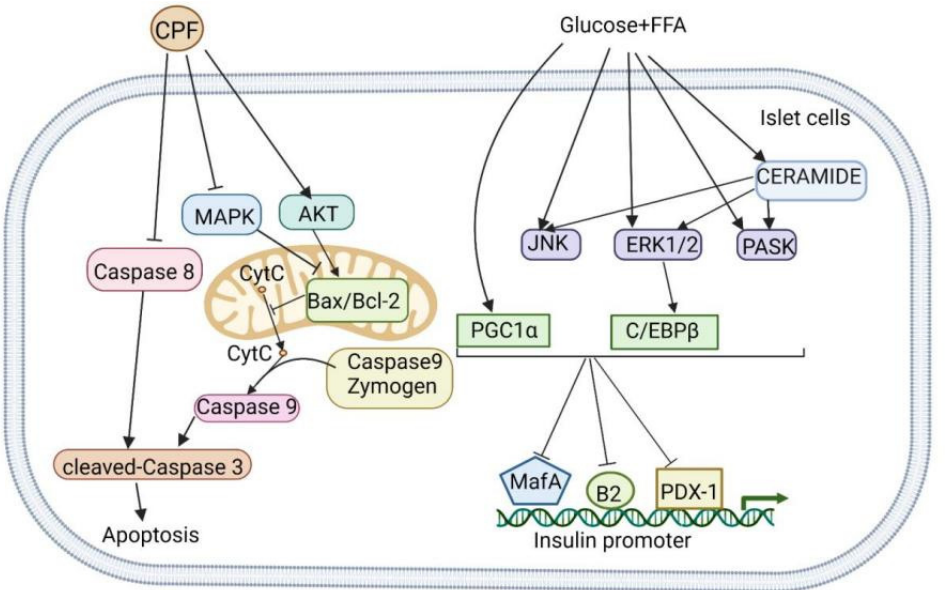
Figure 6. The mechanism of action of Cyclocarya paliurus flavone with respect to alleviating islet cell apoptosis and relatively insufficient insulin secretion caused by glycolipid toxicity.